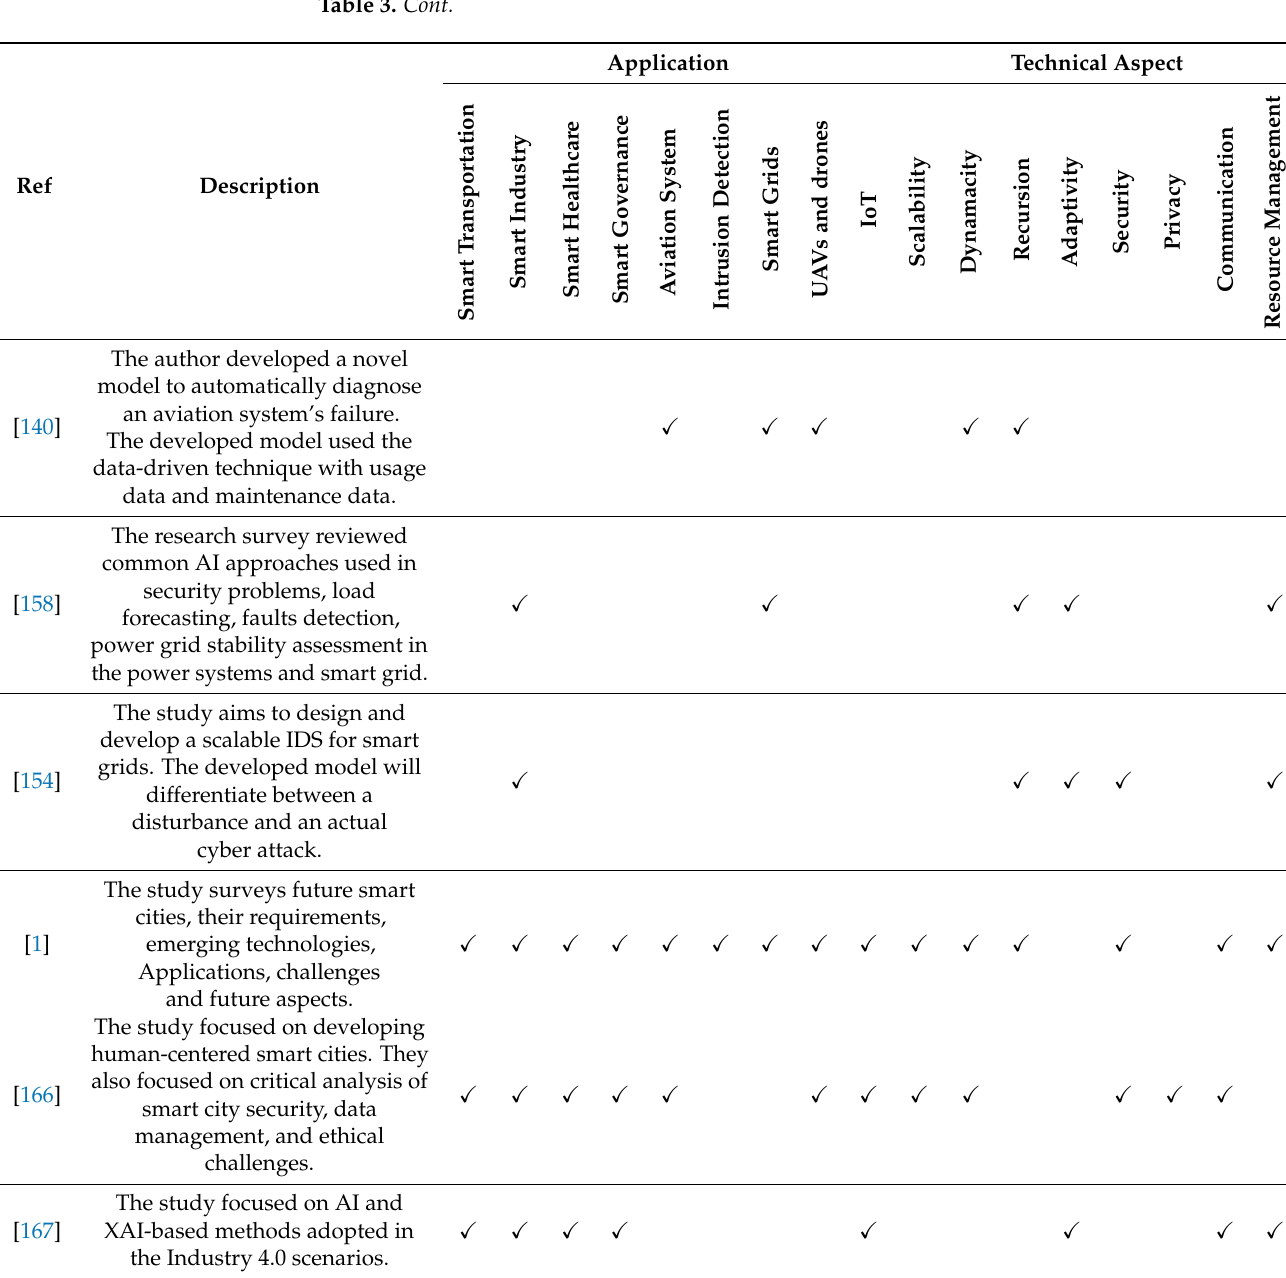
Table 3. Cont. Application Technical